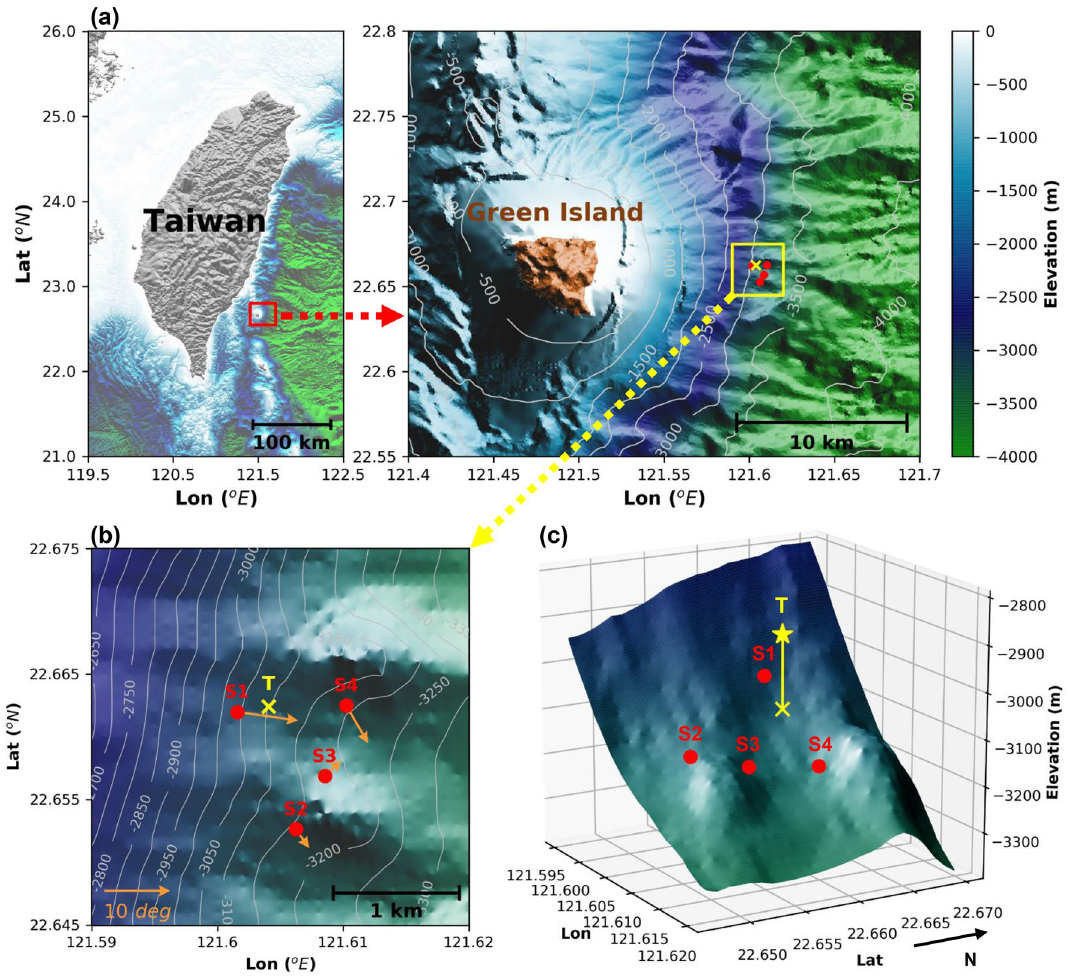
Figure 1. Location of experimental site. ( a ) A small-scale array within a 1 × 1 km footprint was deployed over continental slopes 10 km east of Green Island, Taiwan. ( b ) The array has four broadband ocean bottom seismometers (OBSs, red dots) and a 200-m long vertical thermistor string (T-string, yellow cross). Orange arrows show the magnitude and downslope direction of the local topography at each OBS. Gradients are computed from 100 × 100 m resolution interpolated bathymetry data from a multibeam survey. ( c ) 3D view of the deployed array showing the locations of the OBSs and the T-string with a Nortek AquaDopp acoustic current meter at 2936 m (star). Bathymetric maps were performed using Matplotlib graphic tool (version 2.1.2; URL: http://matpl otlib .org) for